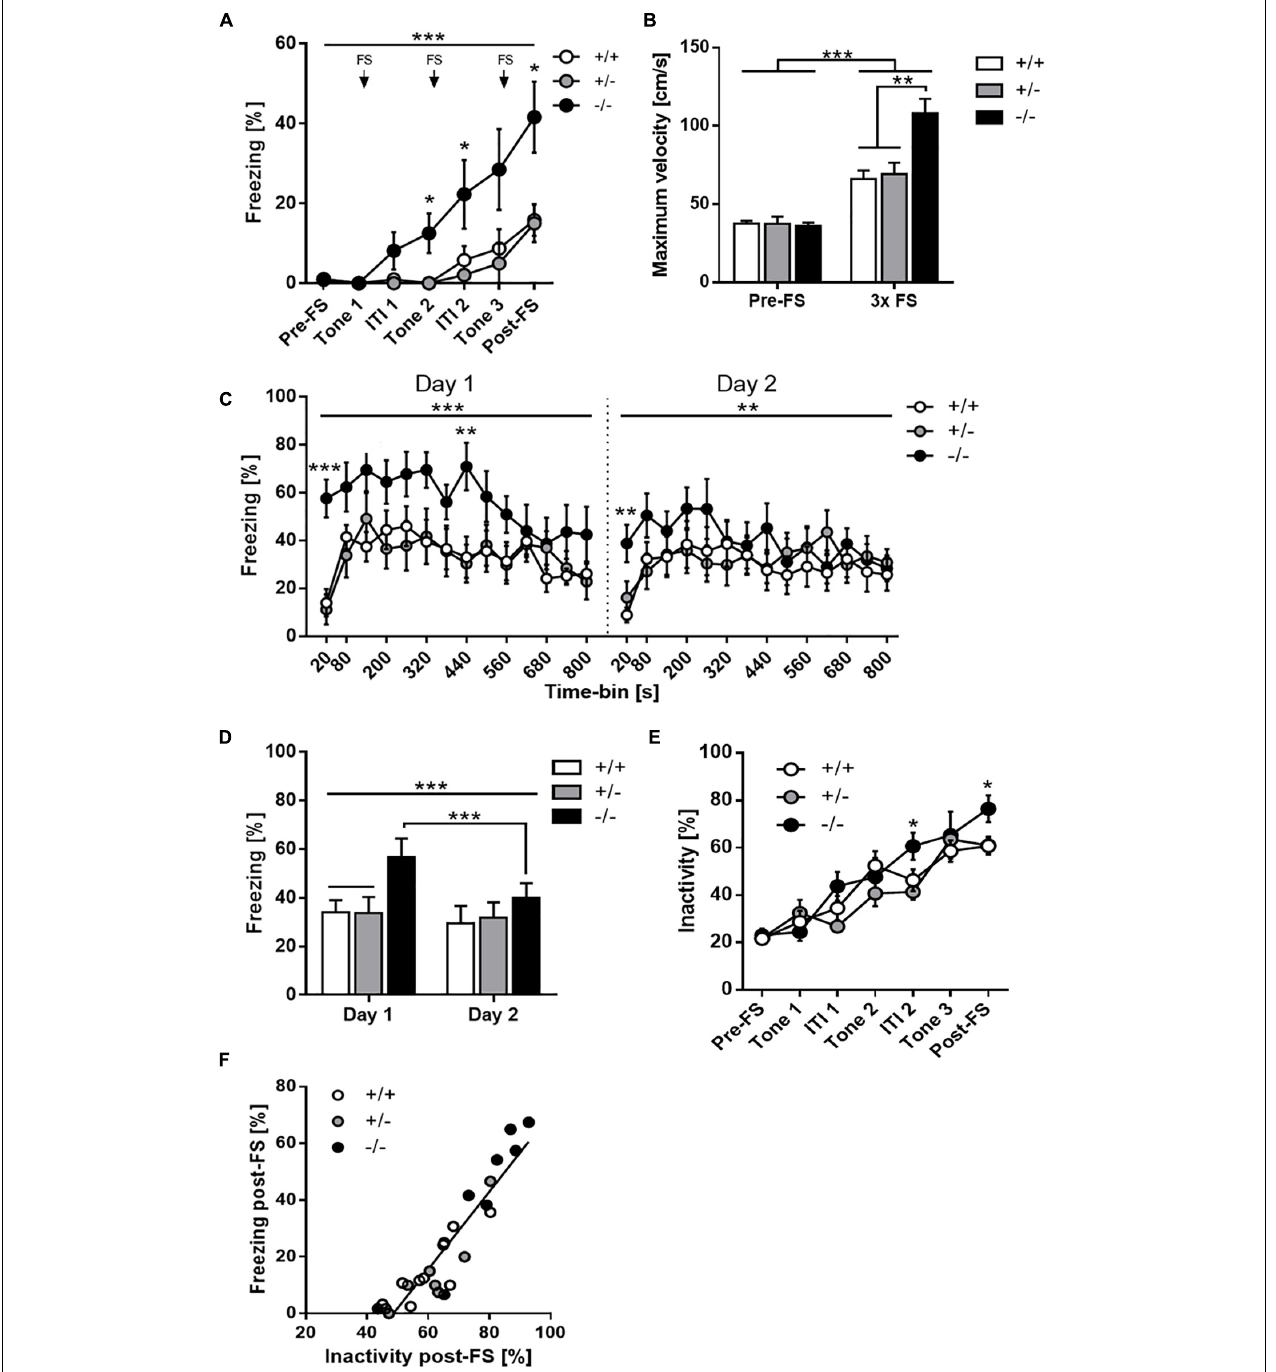
FIGURE 2 | Increased context-dependent fear memory recall but effective contextual extinction learning due to 5-HT deficiency. (A) Time-course analysis of the conditioned fear response of Tph2 + / + , Tph2 + / − , and Tph2 − / − mice during acquisition training showing relative freezing levels before the first pairing of a tone cue with a foot shock (pre-FS), during tone presentations and inter-trial intervals (ITI), and after the last foot shock (post-FS). (B) Unconditioned foot shock reactivity, measured as maximum movement velocity before the first pairing of a tone cue with a foot shock (pre-FS) and following the foot shock (3 × FS). (C) Time-course analysis of the freezing response during contextual fear memory recall and extinction training on day 1 and 2 after conditioning. (D) Average freezing scores in the two extinction sessions. (E) Time-course analysis of the inactivity level during acquisition training showing relative inactivity levels. (F) Positive relationship between freezing scores obtained after the last foot shock (post-FS) in the conditioning session and inactivity scores. Data are shown as means + or ± SEM. ∗ p < 0.05, ∗∗ p < 0.01 and ∗∗∗ p < 0.001.